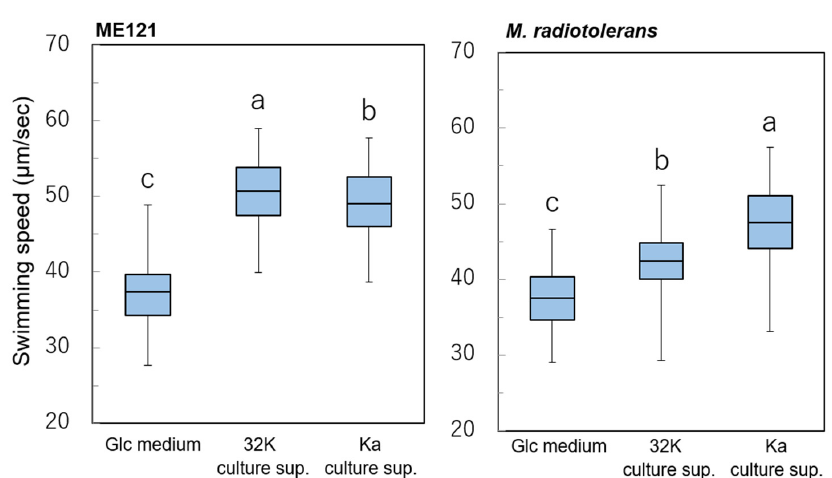
Figure 6. Swimming speed of strain ME121 and M. radiotolerans (Mr) when D-glucose synthetic medium, culture supernatant of strain 32K, and culture supernatant of K. adipata (Ka) were added. Half of the total values are collected in the box, and the thick line in the center of the box shows the average value. The lines that extend vertically are the remaining values, and the edges indicate the maximum and minimum values, respectively. The vertical axis shows the swimming speed ( μ m/s). One-way ANOVA test was performed for equality of all means; ME121: F (2,269) = 225.29, P < 0.001. M. radiotolerans : F (2,239) = 100.20, P < 0.001. Tukey’s test was performed for post hoc analysis, P < 0.05. Different superscript letters (a, b, c) denote significant differences from each other in all combinations.